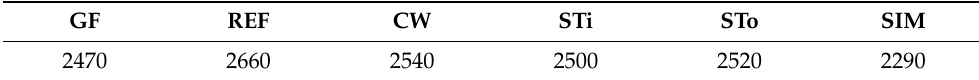
Table 2. Specific gravity of the fillers in kg/m 3 .